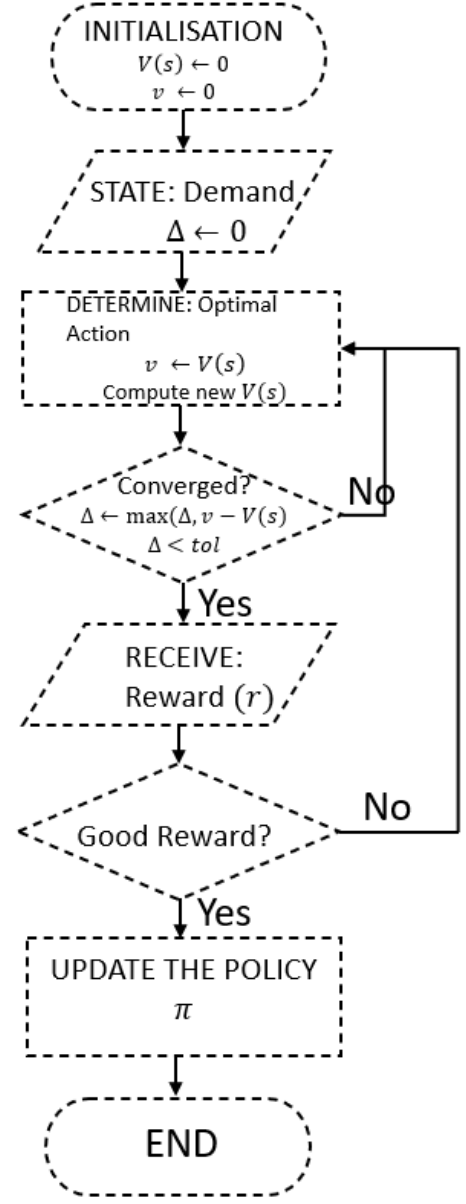
Figure 2. Value Iteration